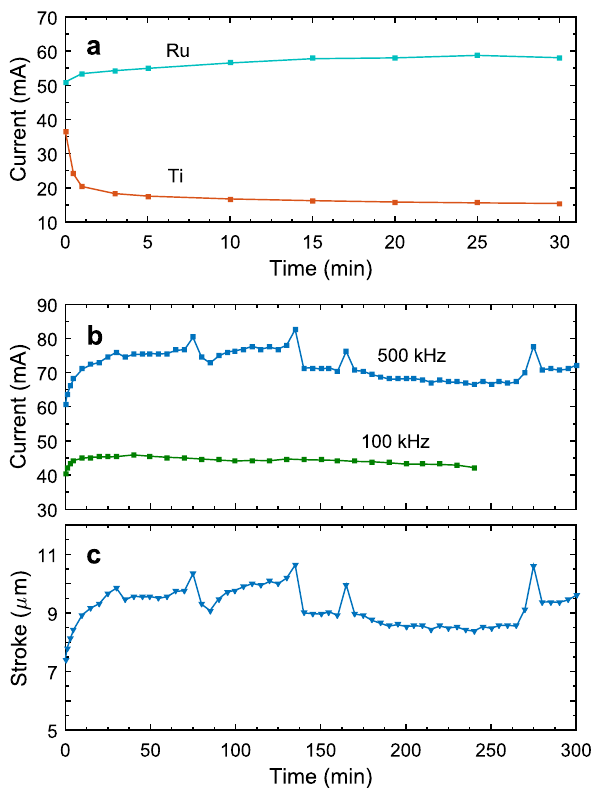
Figure 4. Lone-time performance of the electrodes. ( a ) Current as a function of time through Ru and Ti electrodes shown in Fig. 3. ( b ) Long-time test of the actuator with Ru electrodes. The current as a function of time is shown for the parameters f c = 10 Hz, U = 10.5 V, and f = 500 kHz (blue curve) and f c = 10 Hz, U = 8.1 V, and f = 100 kHz (green curve). ( c ) Stroke of the membrane for the test with f = 500 kHz. The membrane movement reproduces all fluctuations of the